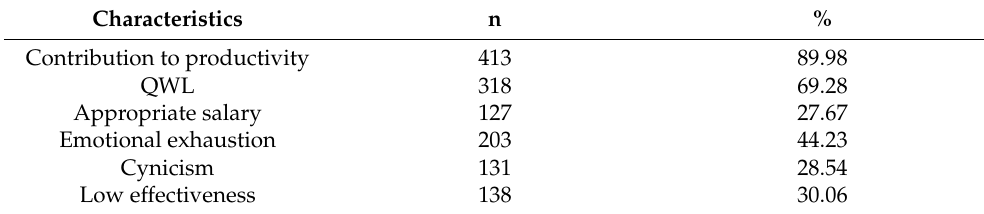
Table 2. Sample characteristics (n =